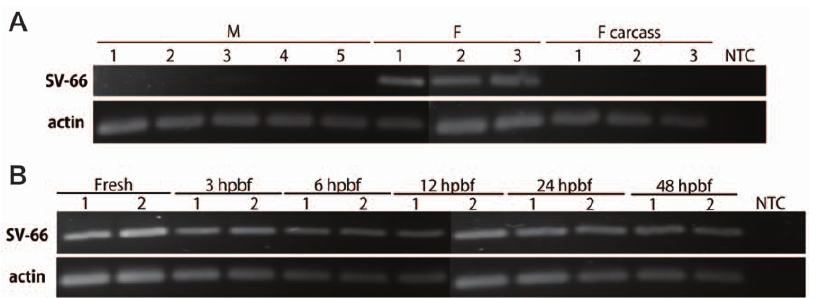
Figure 2. SV-66 is constitutively expressed in the salivary glands of adult female S.vittatum . (A) Sex and tissue-specific expression of Simukunin. Transcript was detected in the adult female body (head and thorax without abdomen), but not in adult female carcasses (bodies without salivary glands or heads). M: male; F: mature female; NTC: no-template control. 5 individuals were pooled for each sample. Actin PCR products are shown as a positive control indicating equivalent concentrations of template among samples. Each panel is a composite of two rows (upper and lower) of wells, run in the same gel at the same time. (B) Time-course of expression of Simukunin. Transcript was detected before, and at selected time points up to 48 h post blood meal. Fresh: freshly eclosed non-blood-fed female adult; hpbf: hours post blood feeding; NTC: no-template control. Two samples, each comprised of 5 pooled individuals, were analyzed for each time point.